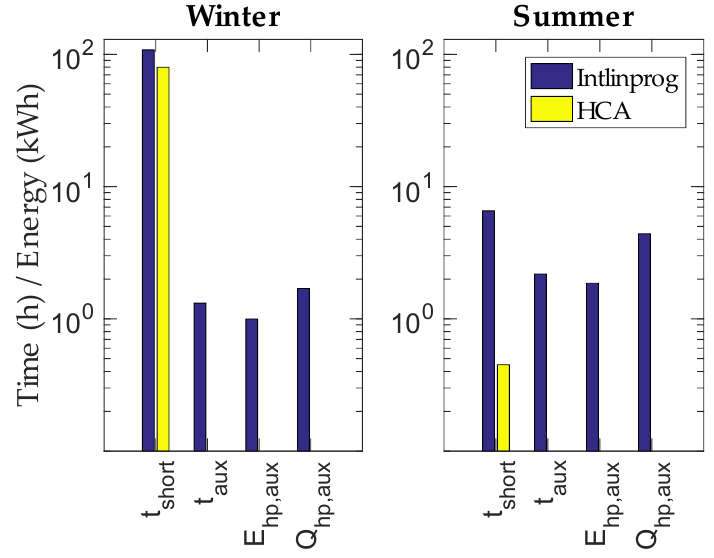
Figure 7. Values of domestic hot water deficit duration ( t short ), heat pump electric and thermal energy supply and running time ( E hp,aux , Q hp,aux and t aux ) calculated by the instantaneous control algorithm (ICA) to compensate for unexpected real-time temperature drops below the set point, prompted by heavy DHW consumption peaks, as well as time step and COP differences between simulation and optimisation. Winter and summer simulations are performed using a heuristic-based algorithm (HCA) and linear optimisation ( intlinprog ) solver. The system consists of a 1-kW heat pump, 600-L domestic hot water tank and 3-kWp PV